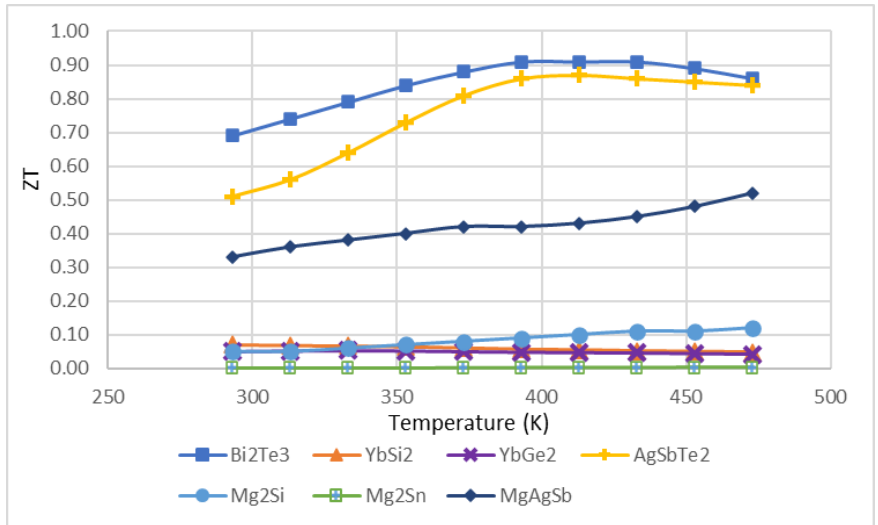
Figure 4. The thermoelectric performance of market standard thermoelectric materials over the low-temperature range: Bi 2 Te 3 has the best performance across the entire low-temperature range with a peak ZT of 0.91. AgSbTe 2 performs comparably, with a peak ZT of 0.84 and efficiency of 7.79% at 473 K. There is a sizeable jump down in the performance of MgAgSb. Its ZT starts at 0.33 and finishes at 0.52 at 473 K.